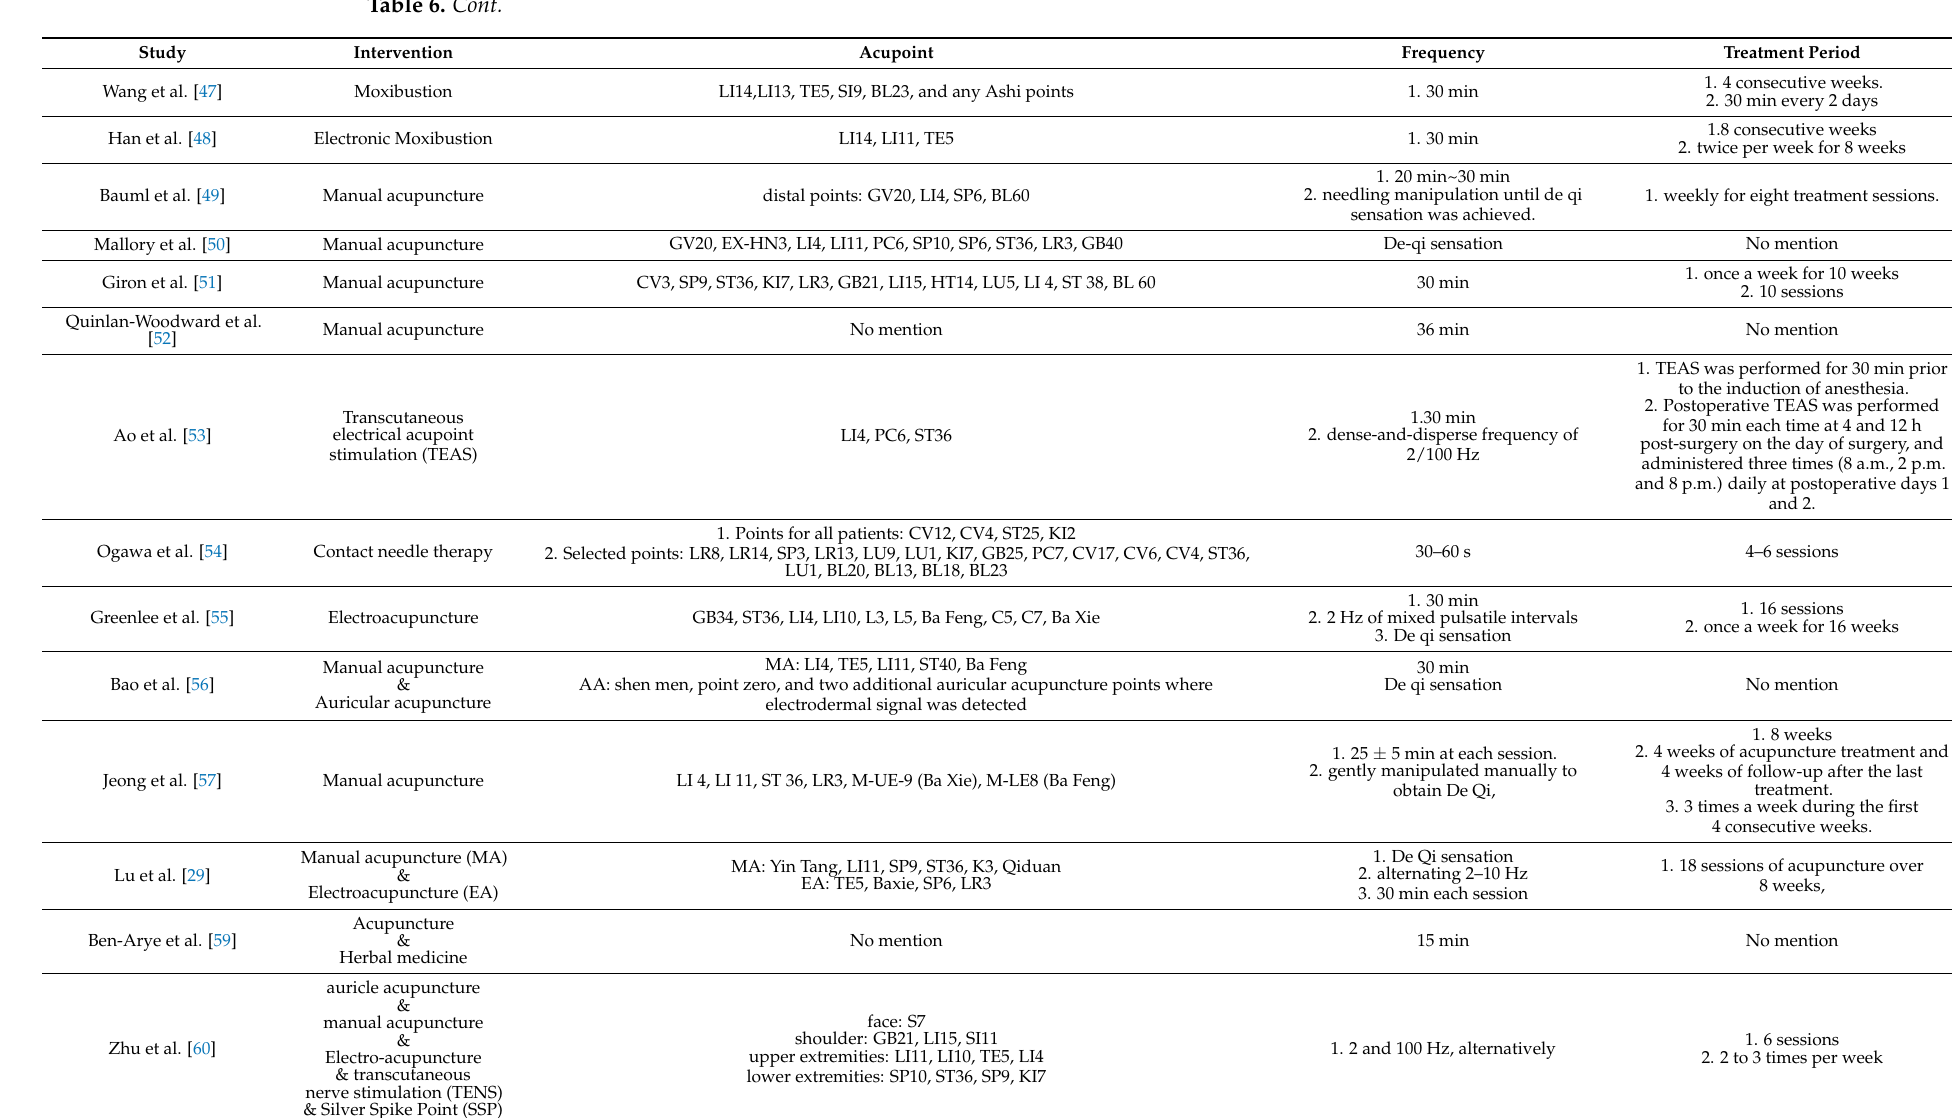
1. Points for all patients: CV12, CV4, ST25, KI2 2. Selected points: LR8, LR14, SP3, LR13, LU9, LU1, KI7, GB25, PC7, CV17, CV6, CV4, ST36, LU1, BL20, BL13, BL18,